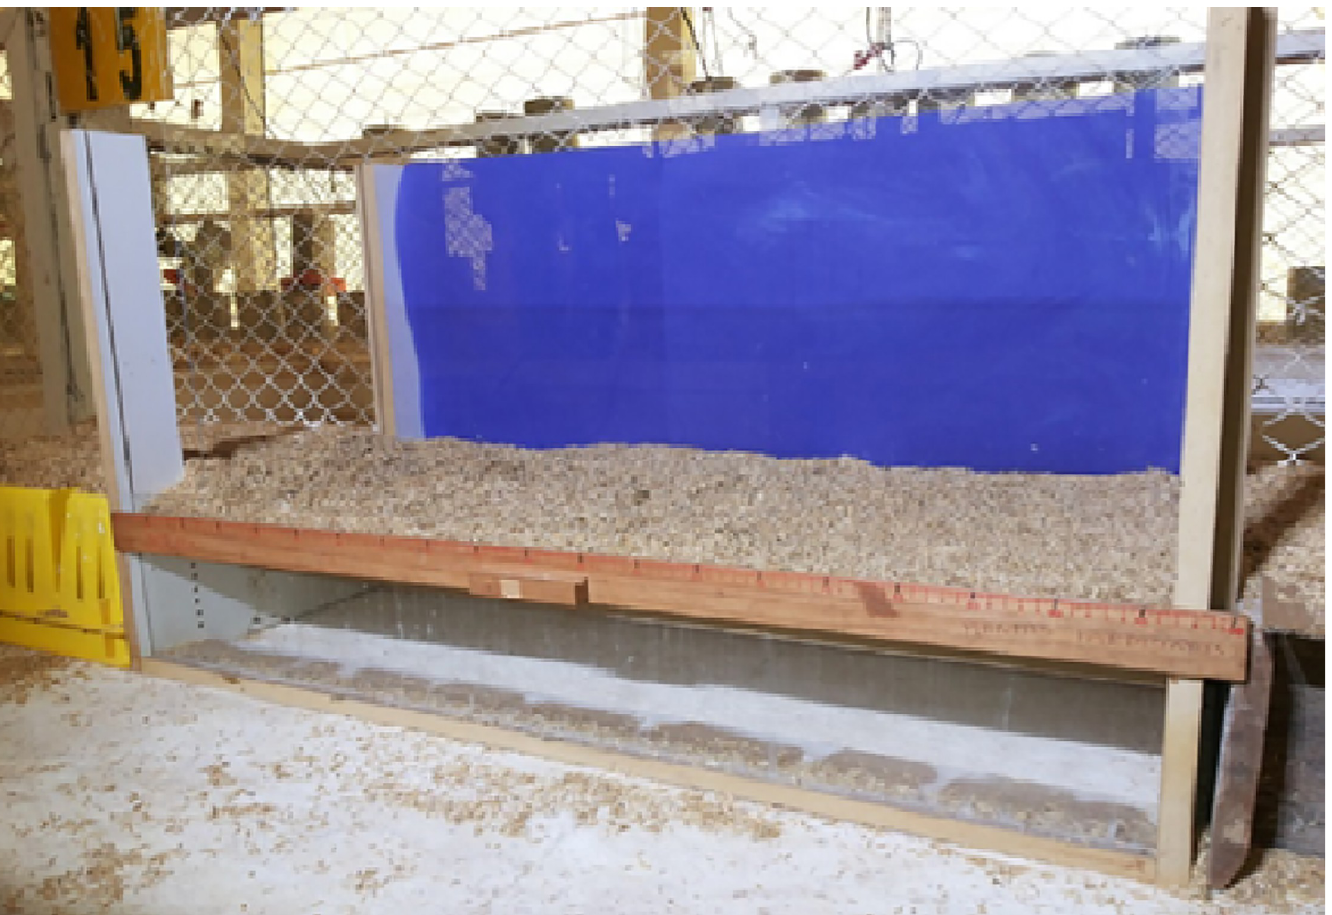
Fig 1. Test area 1 m x 30 cm, flat surface, and 8 cm deep aviary bedding (wood shavings), 50 cm tall acrylic plates were placed at the sides of the track.